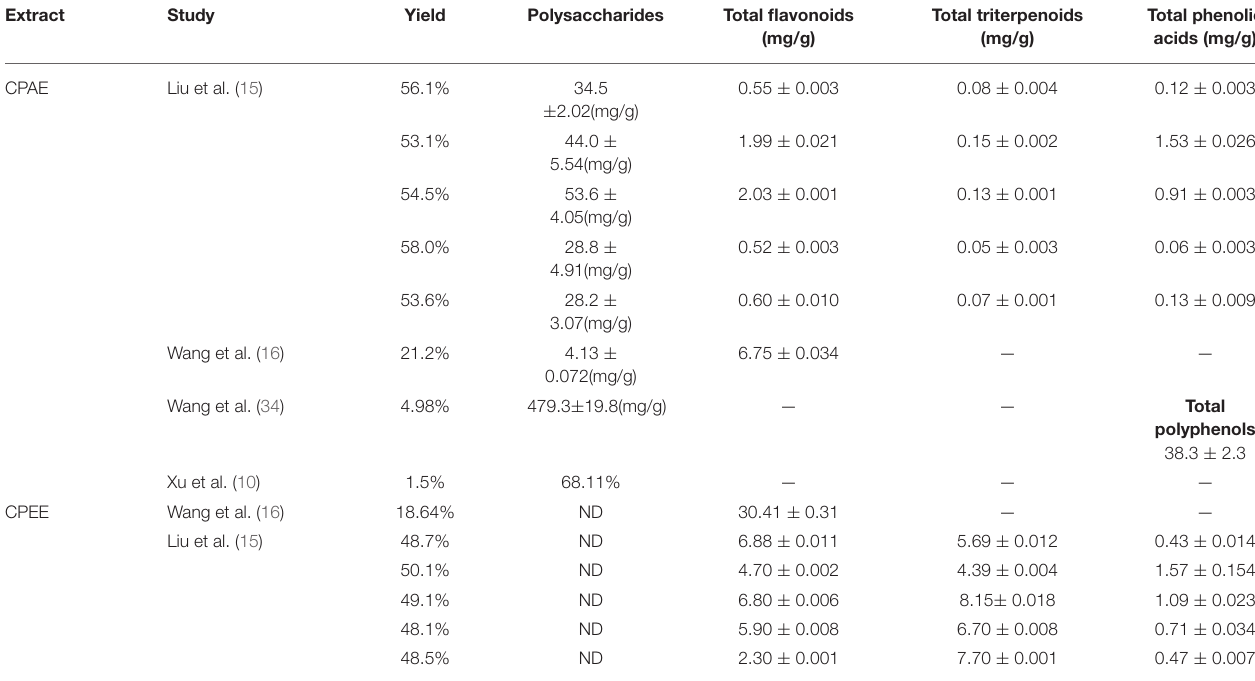
TABLE 2 | Constituents detected from aqueous and ethanol extract of Cyclocarya paliurus .